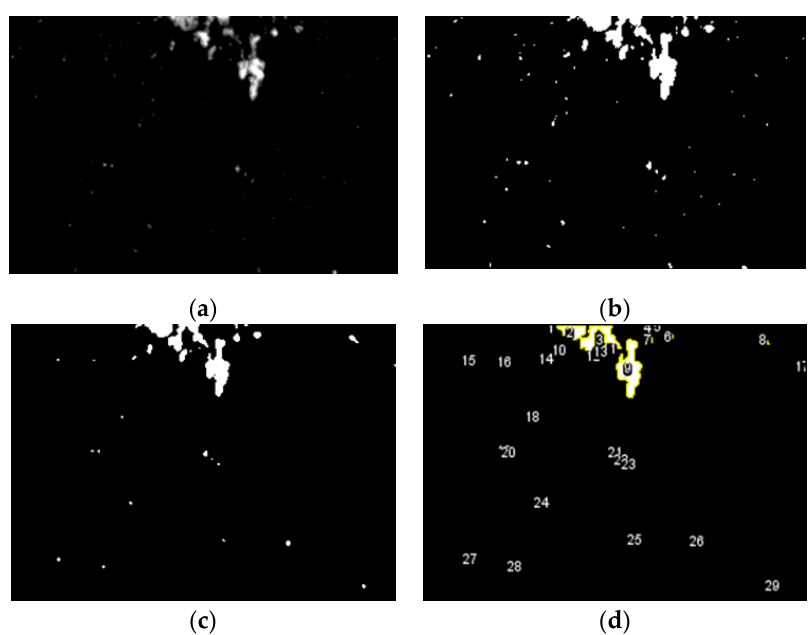
Figure 5. Image processing procedure. ( a ) Original image, ( b ) threshold correction, ( c ) noise reduction, and ( d ) particle tracking.